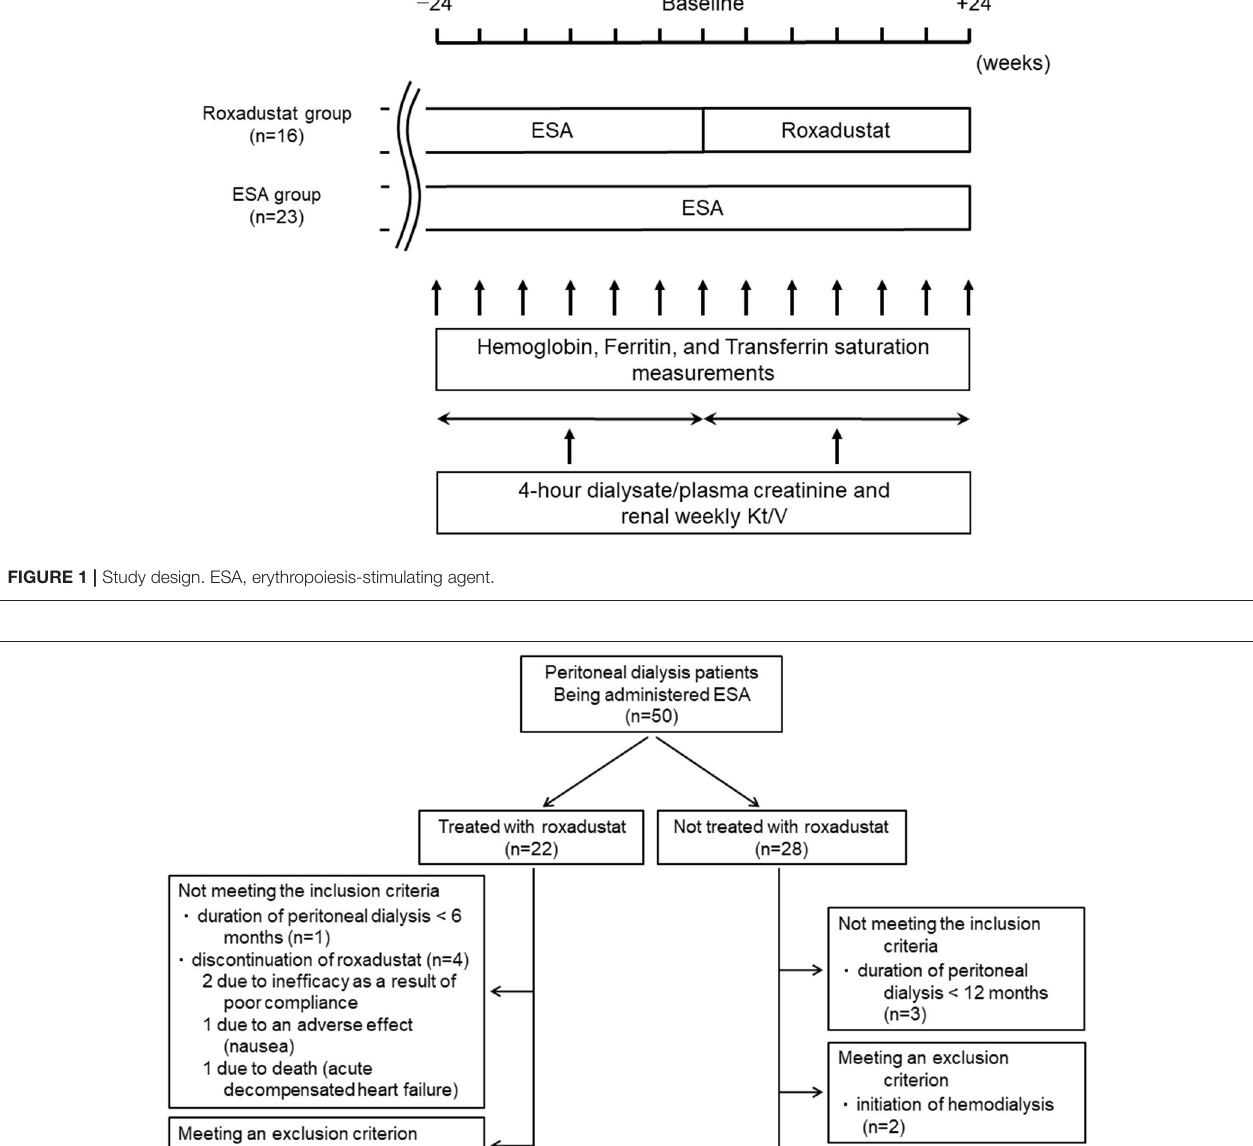
patients and injection pain in 20 patients. Five patients who were treated with roxadustat did not meet the inclusion criteria and one patient met an exclusion criterion, which meant that 16 patients comprised the Roxadustat group. Three patients who were treated with an ESA alone did not meet the inclusion criteria and two patients met an exclusion criterion, resulting in the inclusion of 23 patients in the ESA group ( Figure 2 ). Therefore, data from 39 patients (23 men and 16 women, mean